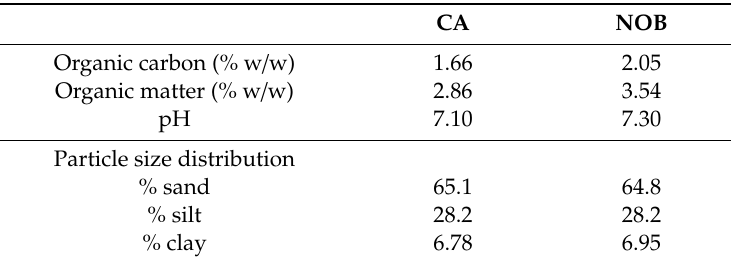
Table 1. General characteristics of the